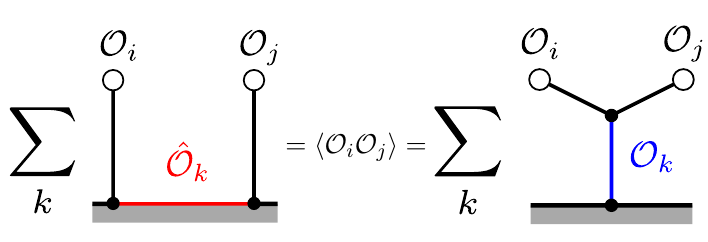
Figure 1 . The two-point function of two operators O i and O j can be expressed in two ways: via the BOE (left) and the OPE